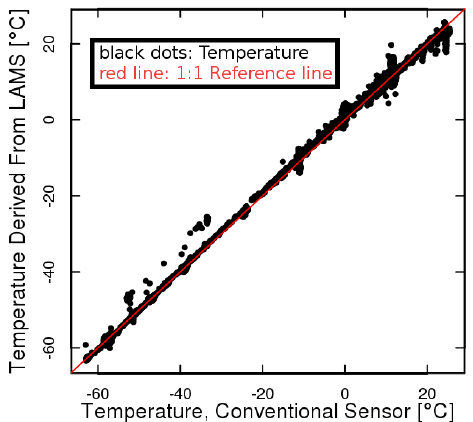
Figure 7. Temperature determined from LAMS using Eq. (24) plot- ted as a function of the corresponding direct measurement of tem- perature for the ferry flight from Colorado, USA to St. Croix, Virgin Islands, on 10 August 2010. Each plotted point represents a mea- surement representing 1s of